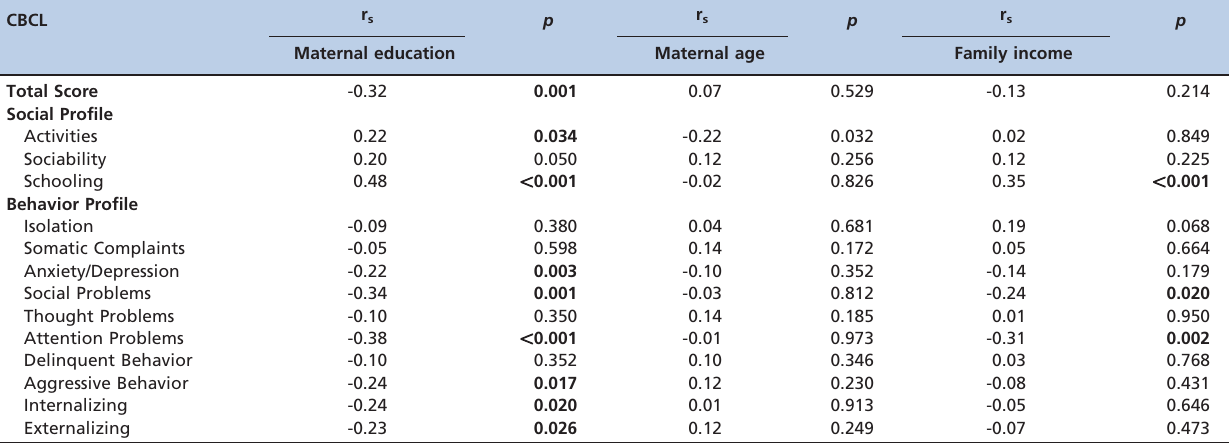
Table 4 - Correlation between the different domains of the Child Behavior Checklist (CBCL) and socioeconomic profile of the sample.